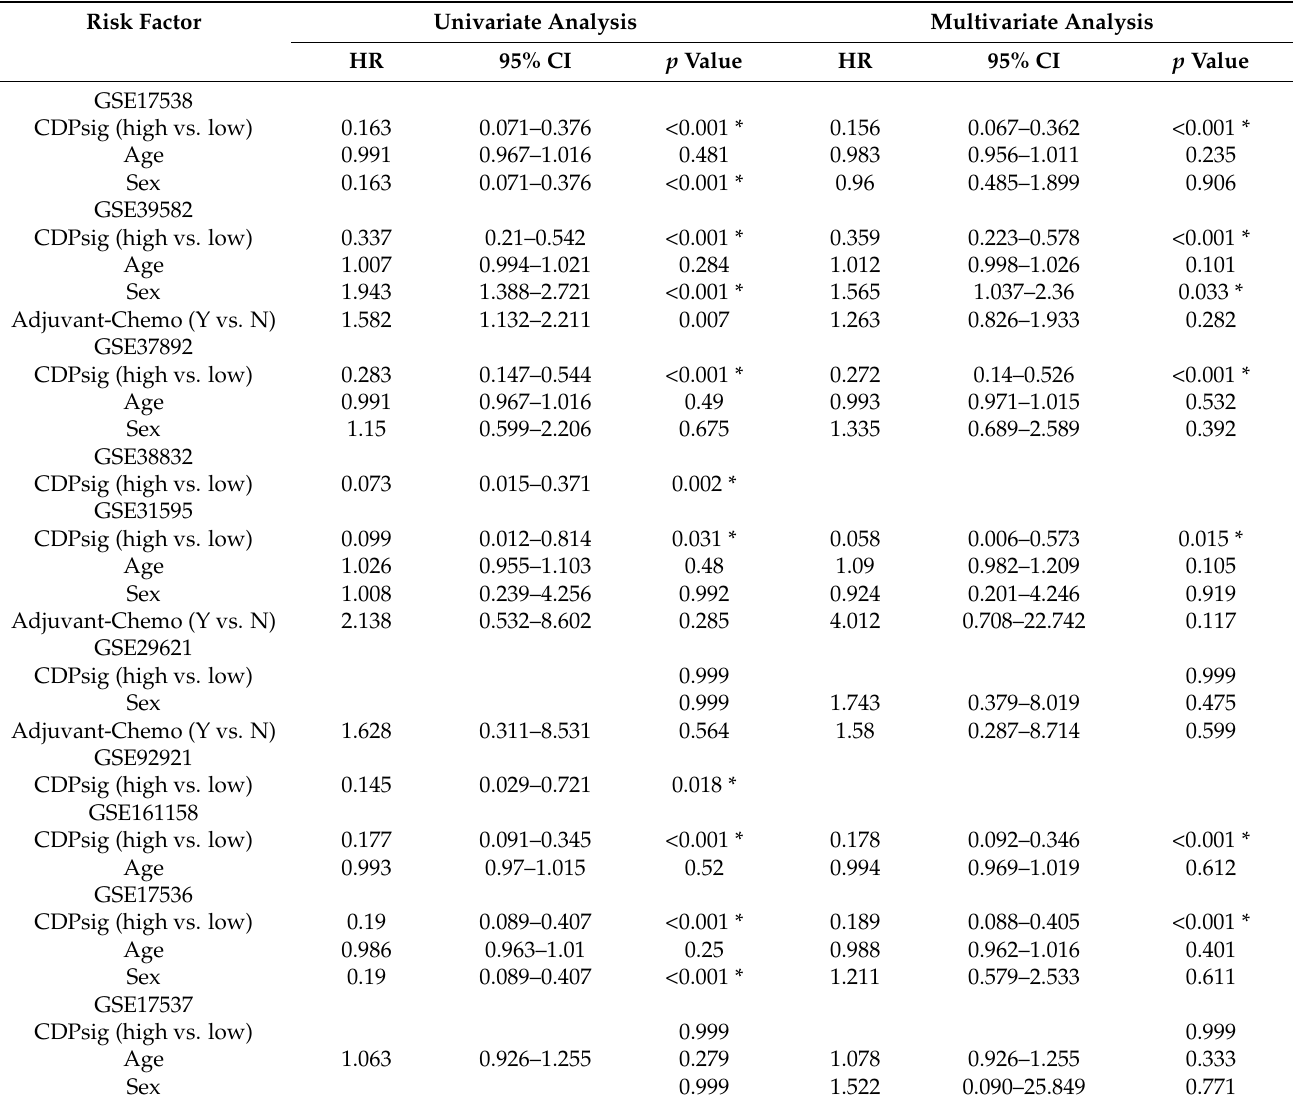
Table 3. Univariate and multivariate Cox regression analysis results of CDPsig in validation datasets. * p <